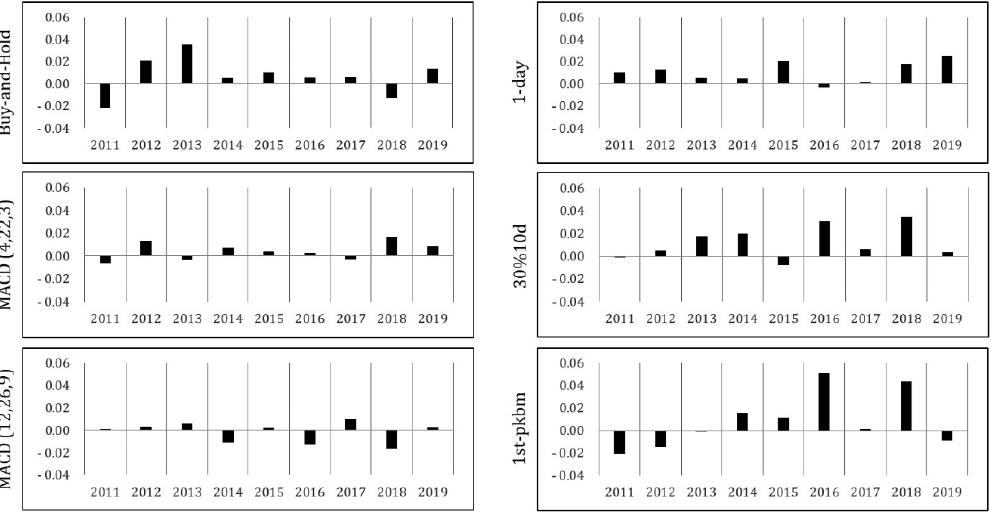
Figure 3. The Yearly Changes in Mean Log Returns of All Models. Note: The length of each bar indicates yearly mean log returns that are calculated from the log returns for every transaction in the year.